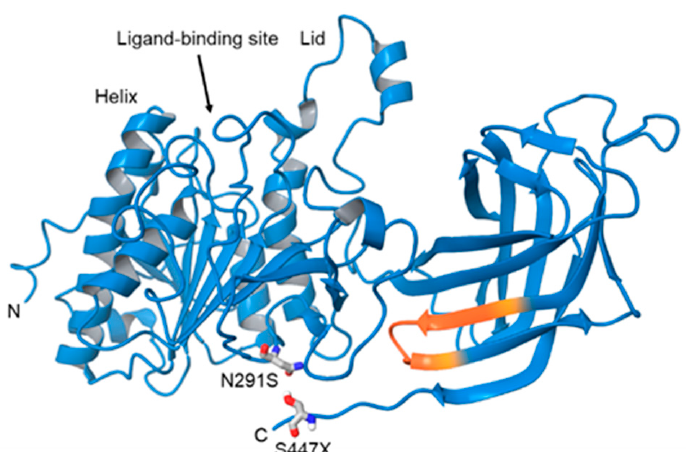
Figure 1. Tertiary structure of LPL. Ribbon representation of human LPL with residues of key mutation sites N291S and S447X shown in stick display style (carbons colored grey), exposed residues 405–414 upon S447X mutation are colored orange on the ribbon. The structure has been modified from the PDB: 6OB0 crystal structure elucidated by Arora et al., as residues K472, K473, S474, and G475 were added to the C -terminus, using the build feature of the Schrodinger Suite 2018-4. The ligand-binding (active) site situated between the lid and lid-proximal Helix. The N291S (residue 318) mutation, and S447X (residue 474) mutations are labeled. Hayne et al., proposed that truncation of the C -terminus via the S447X mutation, results in the exposure of a lipoprotein receptor binding site at residues 405–414 (highlighted in orange), suggesting increased lipoprotein receptor binding in this variant.